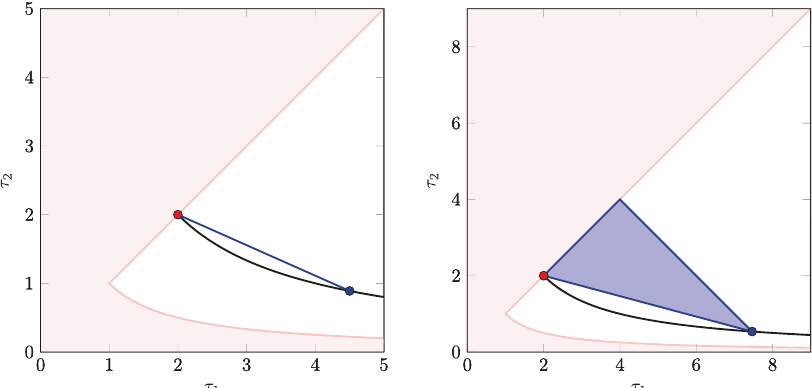
Fig. 6 Conversion of quantum athermality to a classical form. The region enclosed by the solid blue line marks all single-mode states accessible by BLTO starting from a single-mode (left) and a two-mode (right) squeezed thermal state at the same temperature as the bath ’ s. The solid black line shows all squeezed thermal states at the bath temperature. The examples illustrate that genuinely quantum resource in the form of squeezing can be converted to a classical form of resource temperature differential relative to the